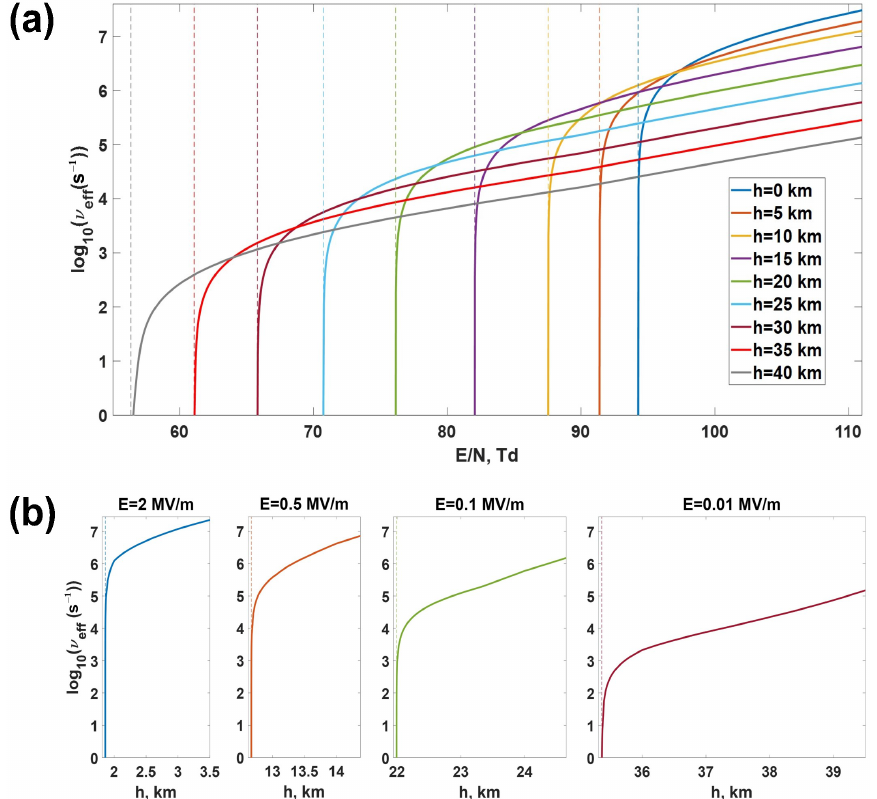
Figure 3. Dependence curves of the model-predicted effective ionization frequency ν eff ( a ) on the reduced electric field E / N for different altitudes AMSL and ( b ) on the altitude AMSL h for different values of the electric field E . Vertical dashed lines stand for reduced critical electric fields E c / N (in panel ( a )) and altitudes (in panel ( b )) at which the discharge development